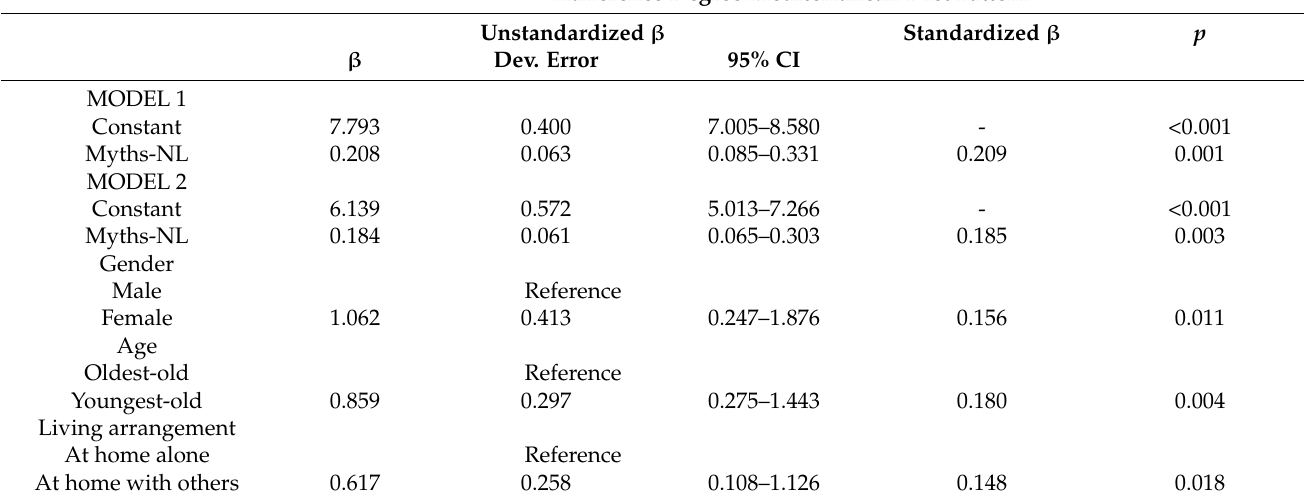
Table 3. Regression analysis between estimated nutrition literacy, sociodemographic factors and adherence to Mediterranean diet pattern ( n =